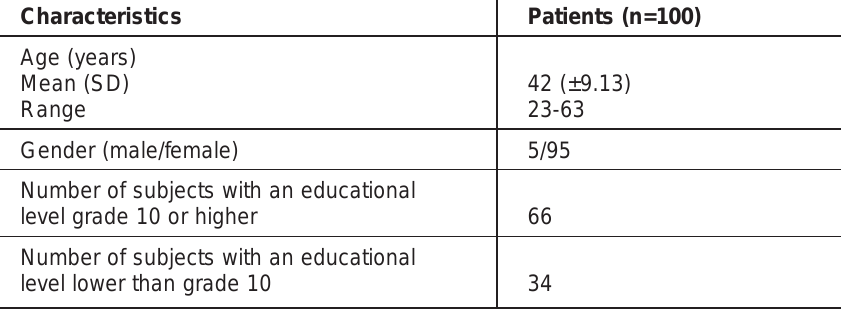
Table 1: Demographic Data